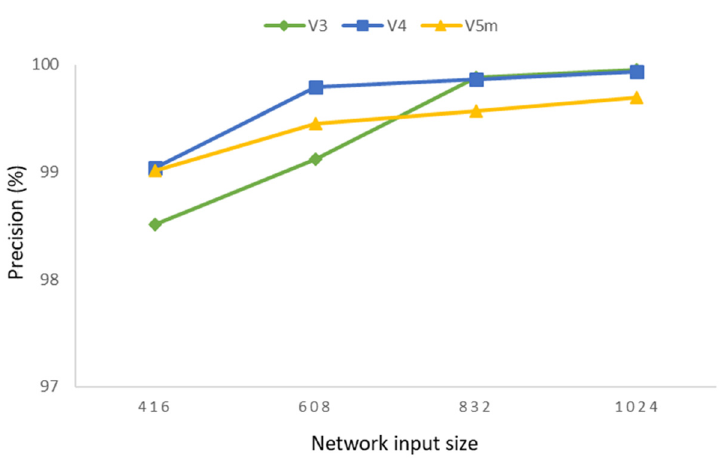
Figure 8. Comparison of the precision values of YOLOv3, YOLOv4, and YOLOv5m.